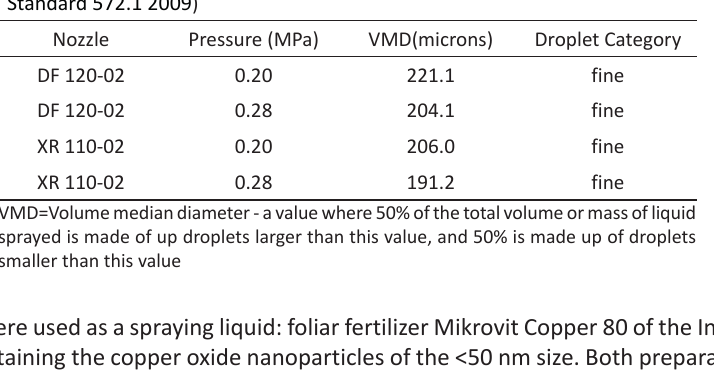
Table 1. Results of the droplet category for the tested nozzles at a pressure of 0.20 and 0.28 MPa, determined according to the ANSI/ASAE S572.1 (